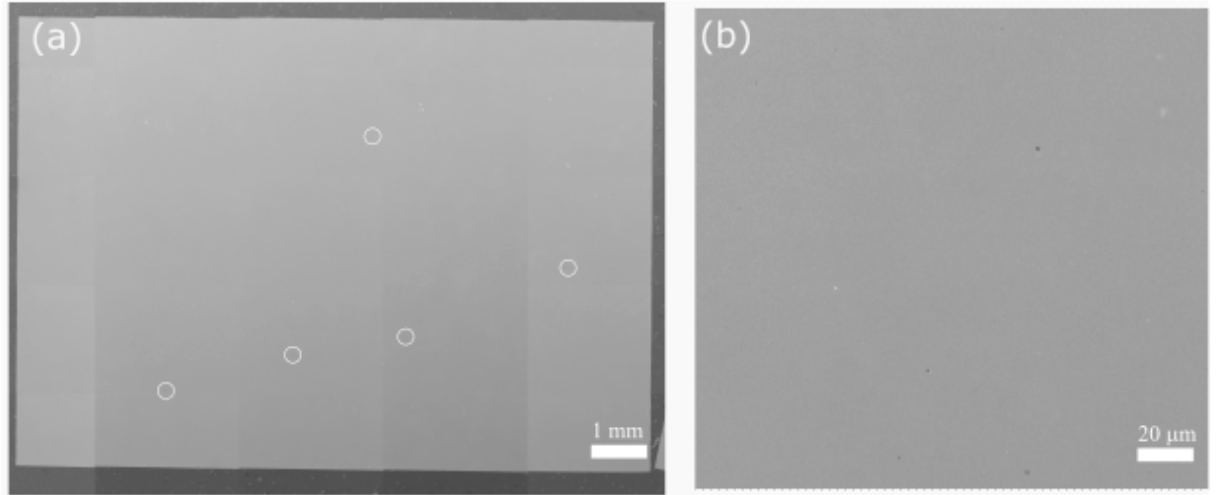
Figure 4. As-polished SEM micrograph of ( a ) the cross-section of the AB specimen along with ( b ) a representative higher magnification image. The white circles in ( a ) demarcate small gas pores in the AB IN718.